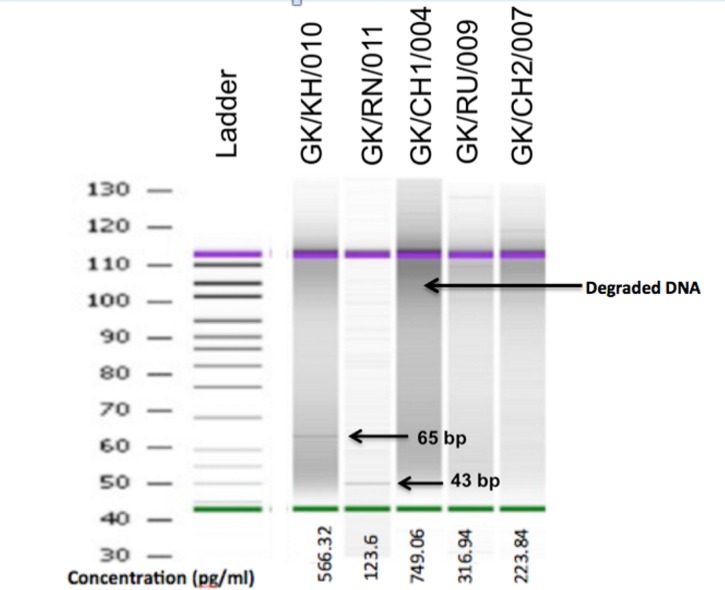
Quantification of fossilized DNA.Bioanalyzer image showing bands of 65 bp and 43 bp in GK/KH/010 and GK/RN/011 respectively. Concentration of DNA in pg/ml of five samples, calculated by bioanalyzer.